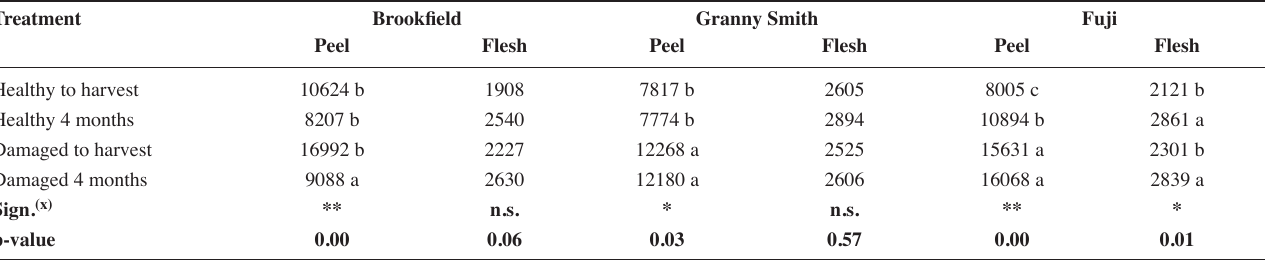
Tab. 5: Quantification of ORAC (μmol of Trolox equivalent/100g) in peel and flesh of healthy and sun-burned apple, of conventional orchard, from harvest to 4 months of cold storage. Season 2012/2013. Treatment